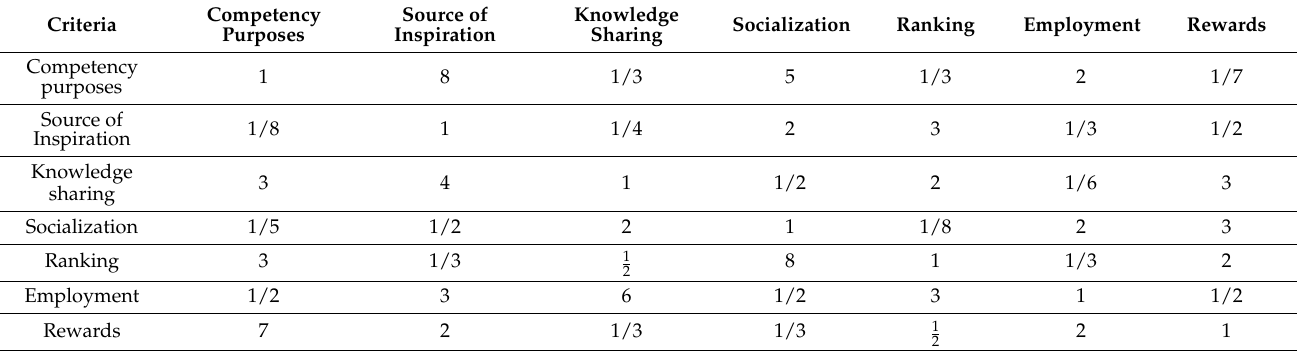
Table 2. Pairwise decision matrix.